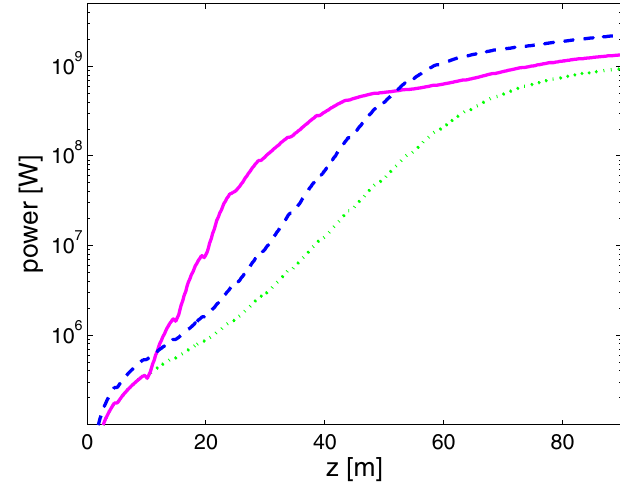
FIG. 8. (Color) SASE FEL power along the undulator at a peak current of 2 kA without any optical klystron (blue dashed curve) and with 4 optical klystrons (magenta solid curve), and at peak current of 3 kA without any optical klystron (green dotted curve). The FEL wavelength is 1 : 5 (cid:1)A and the undulator parame- ter K (cid:1) 1 : 3 .